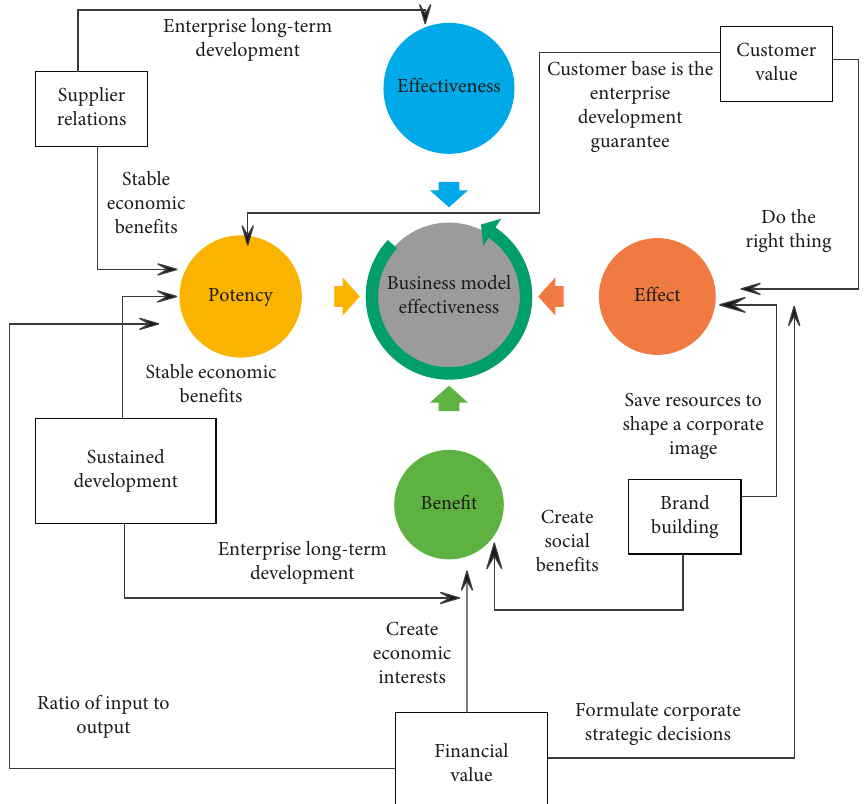
Figure 4: The mechanism of the effectiveness of the technological startups business